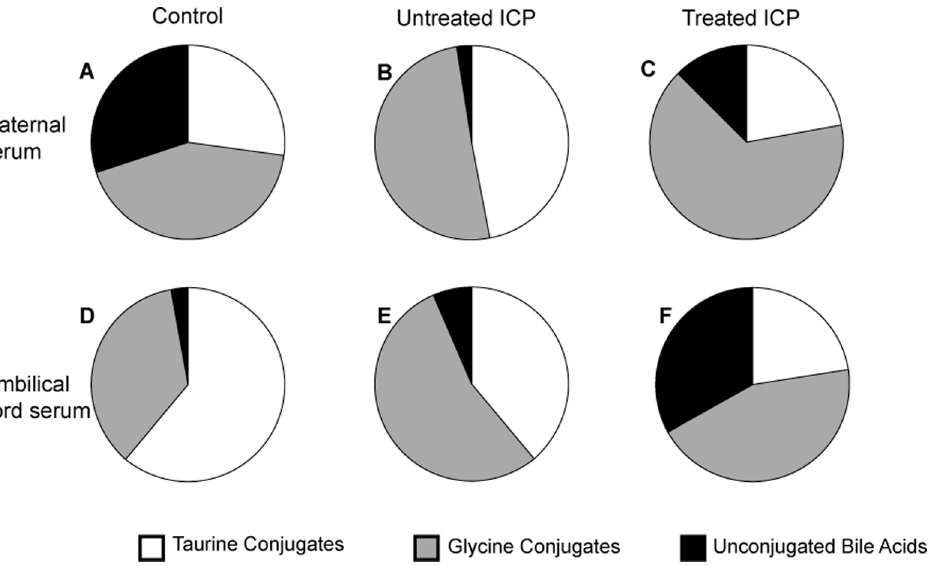
Figure 3. The distribution of unconjugated, taurine and glycine conjugated bile acids in maternal and cord serum. Upper panel shows data from maternal samples from normal (A), untreated ICP (B) and treated ICP (C) pregnancies and lower panel shows data from umbilical cord blood samples from normal (D), untreated ICP (E) and treated ICP (F) pregnancies.